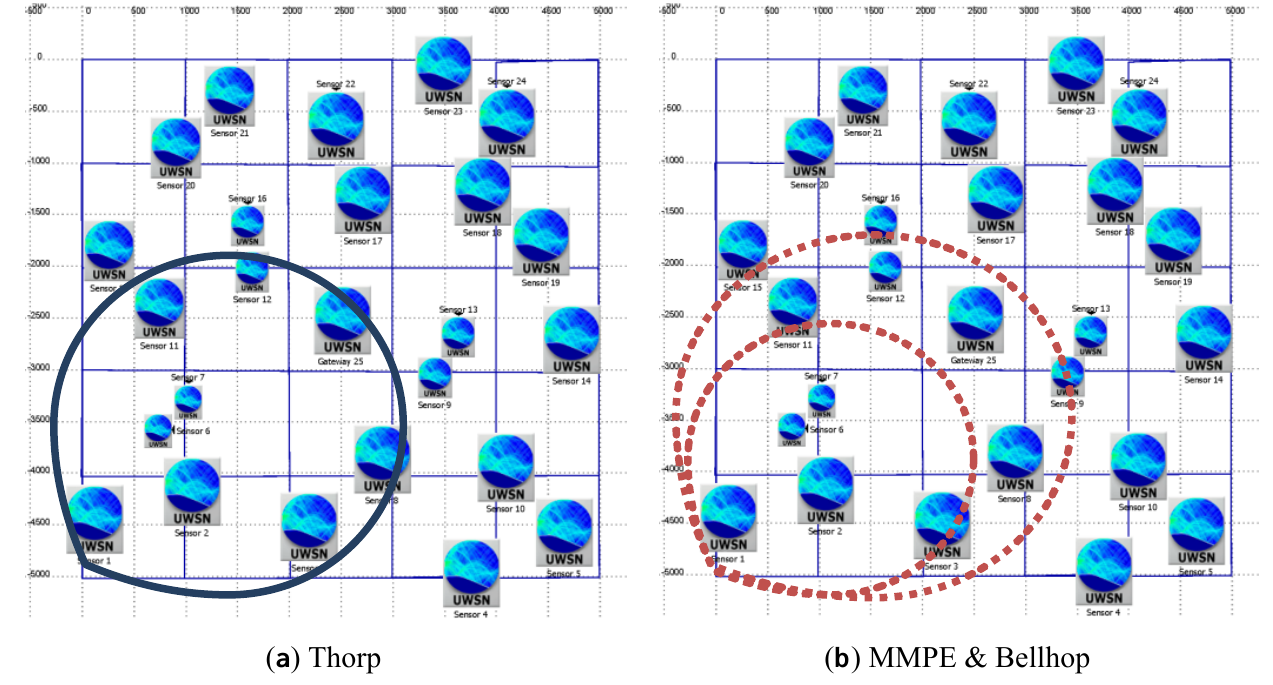
Figure 6. Reachability of gateway from Node #1 (bottom